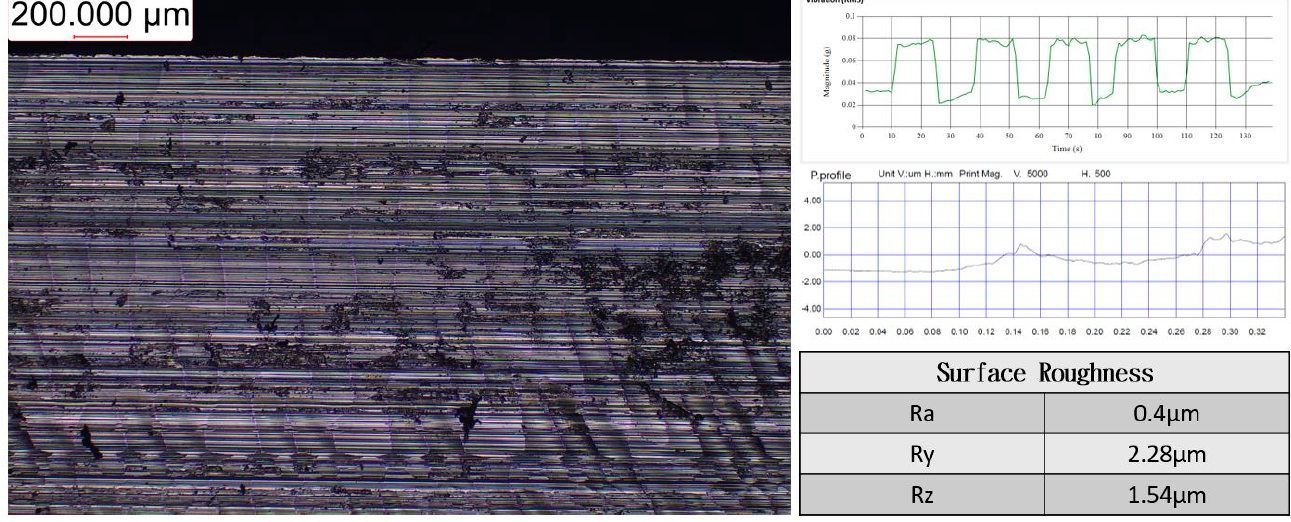
Figure 23. D8 measurement result of Parameter 2.